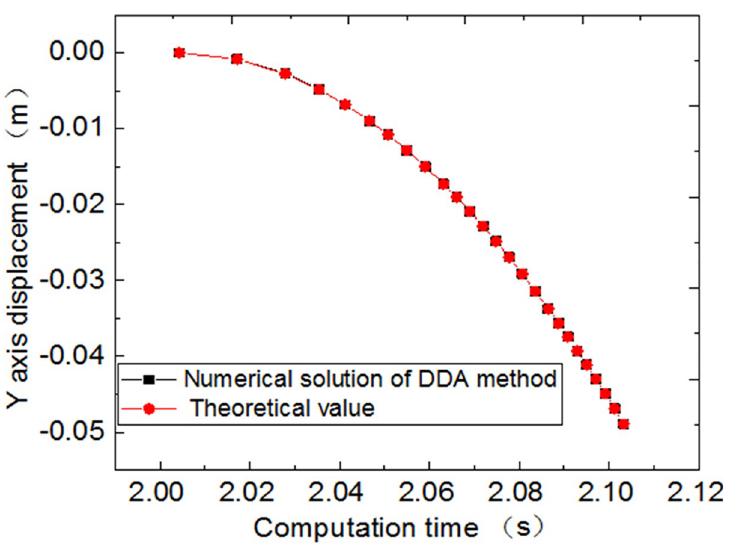
Fig 10. Displacement and time